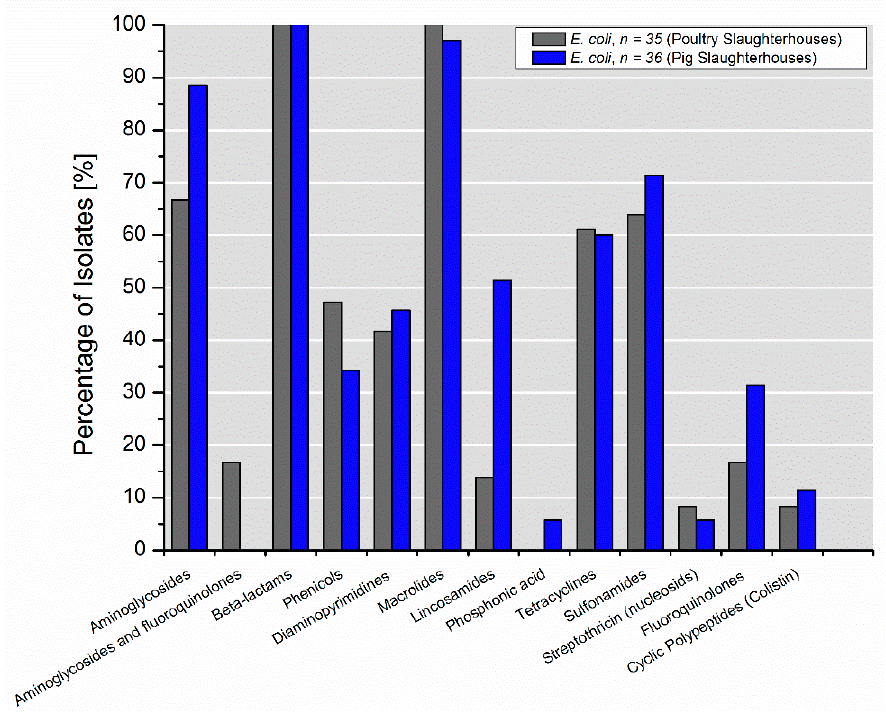
Figure 2. Percentage of selected E. coli isolates ( n = 71) recovered from wastewater and process waters from poultry and pig slaughterhouses carrying genes mediating resistance to the specific classes of antimicrobials.